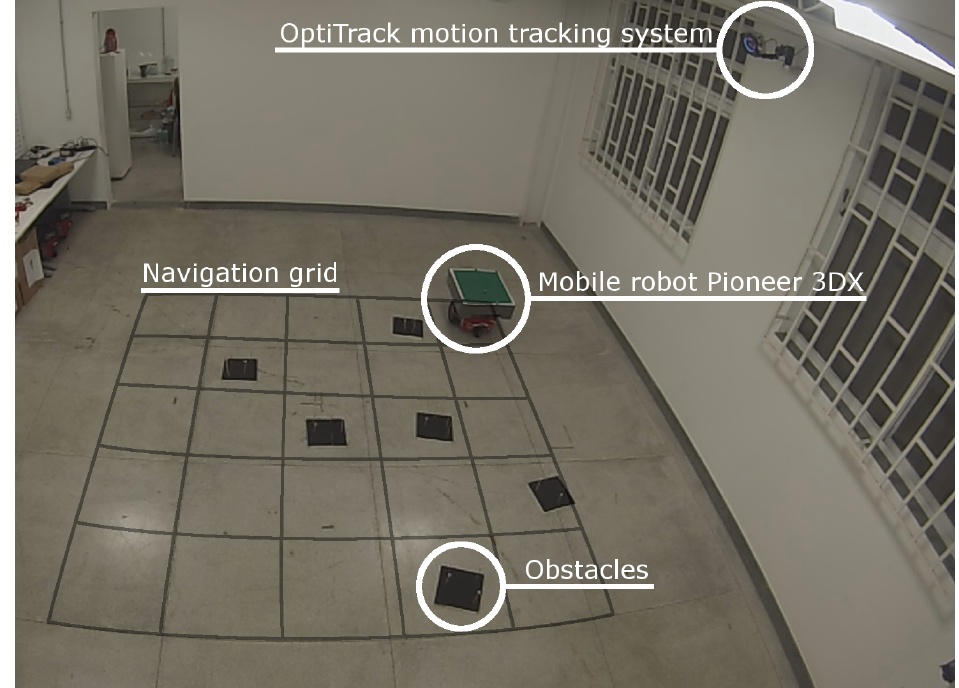
Figure 7. The scenario to be described by a navigation